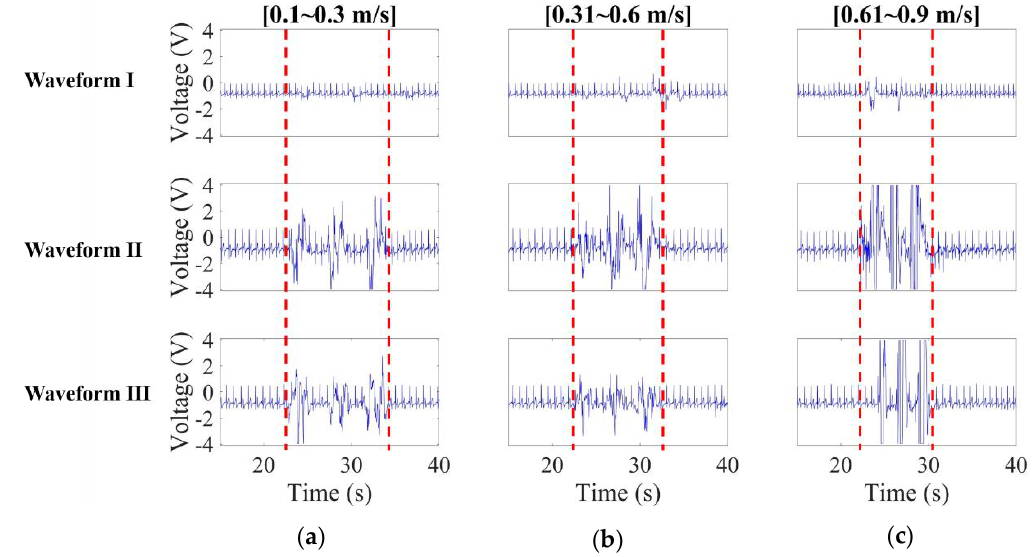
Figure 16. CECG waveform comparison when the human noise source approached the subject at ( a ) 0.1–0.3 m/s (low speed), ( b ) 0.31–0.6 m/s (middle speed) and ( c ) 0.61–0.9 m/s (high speed). As before, red framed in Figure 17a–d are the measured noisy ECG and CECG signals using the electrodes in Figure 3a,b and Figure 7, respectively.